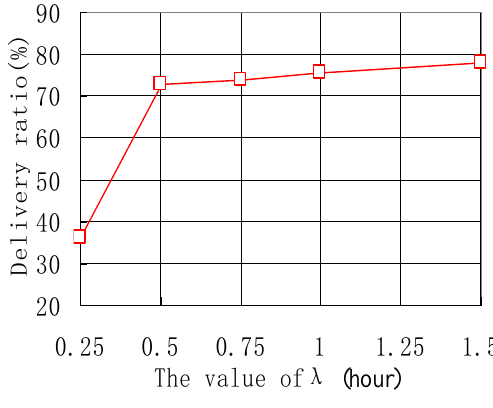
Figure 7. Data delivery vs. value of